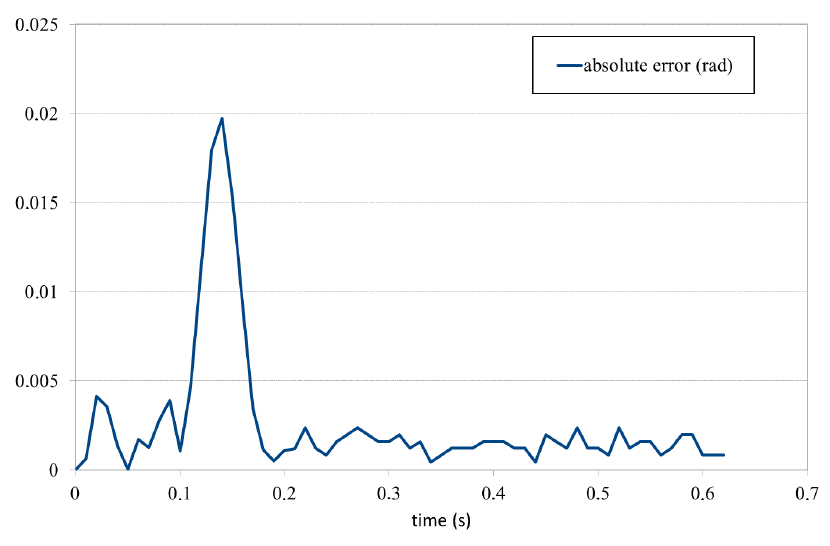
Figure 8. Absolute error (rad) over time